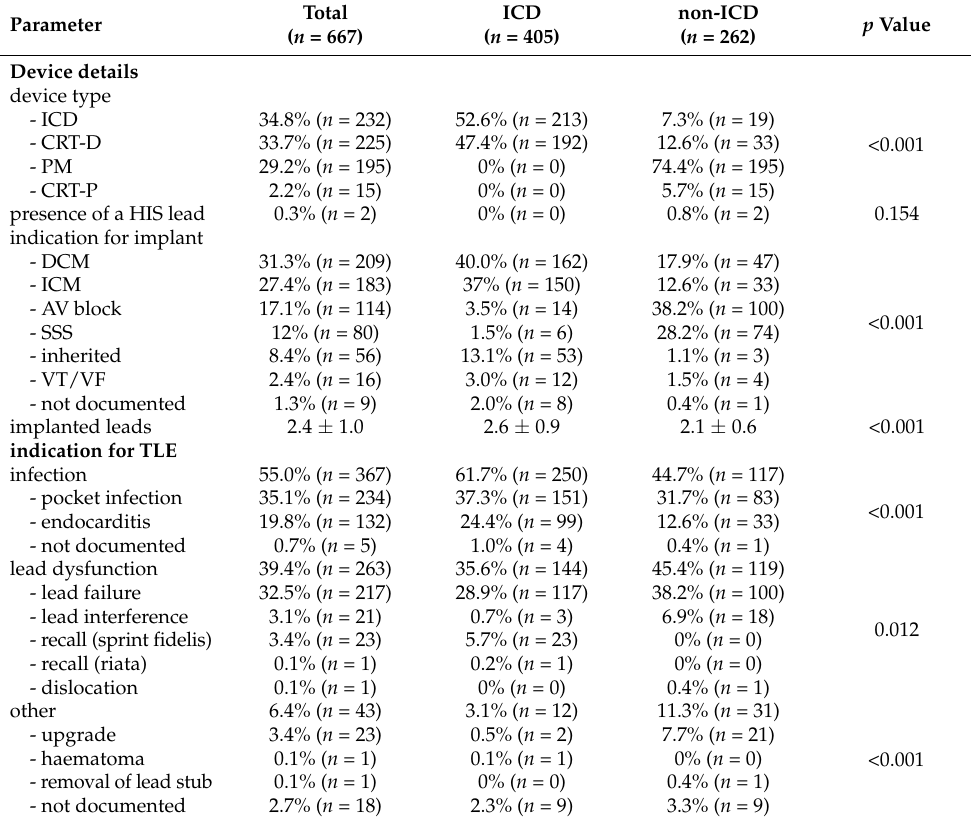
Table 1. Device details and indications for TLE, stratified by ICD and non-ICD groups.